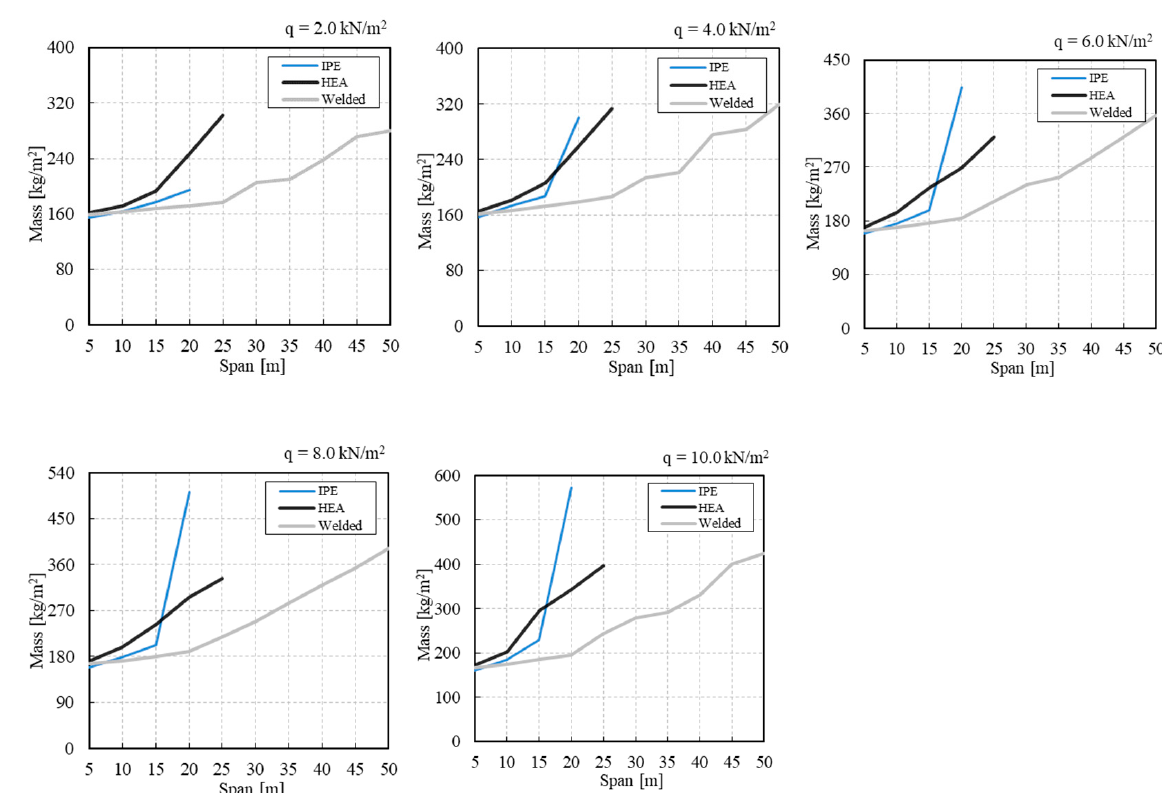
Figure 6. Comparative diagrams of the optimal masses (MASS) of the CFS structures with welded and standard IPE and HEA sections.